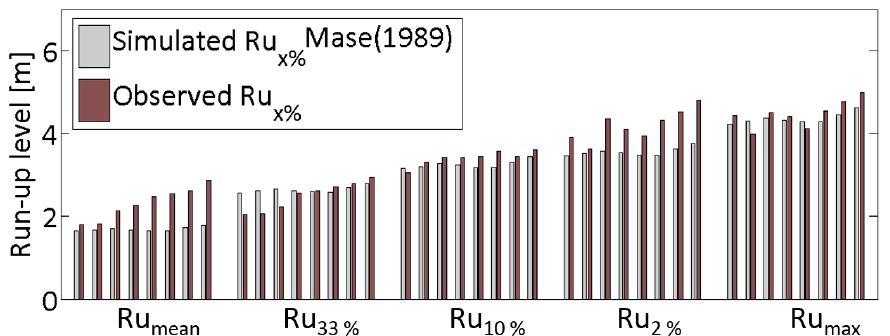
Figure 14. Hourly comparison among different Ru x % values (Ru mean , Ru 33% , Ru 10% , Ru 2% and Ru max ) calculated with Mase (1989) equations and observations. The run-up data are relative to the 10 February 2016 sea storm from 08:00 to